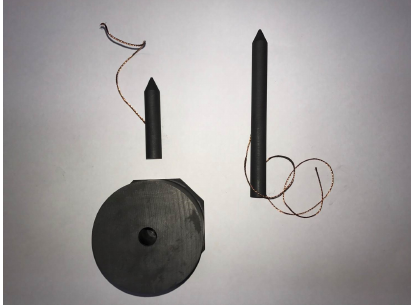
Figure 3: Graphite rod electrode